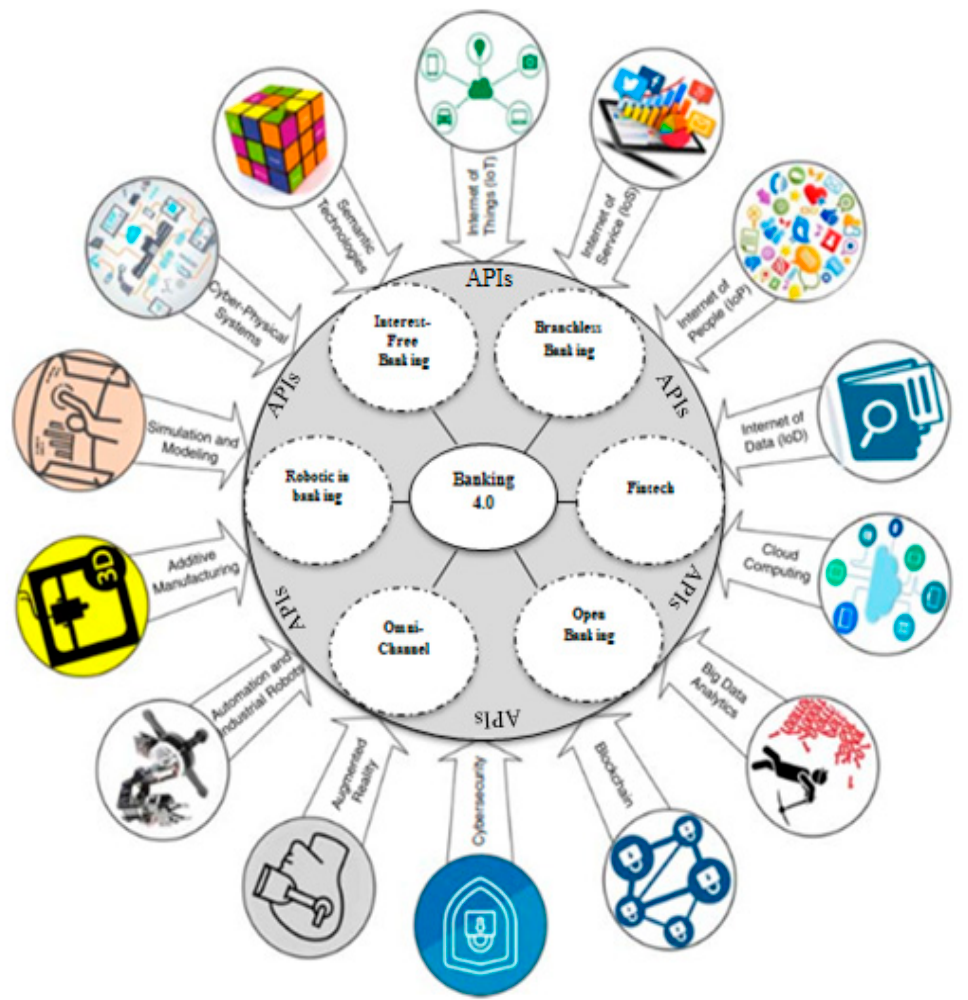
Figure 14. Design principles of Banking 4.0 in Industry 4.0. Source: Own contribution of the authors.